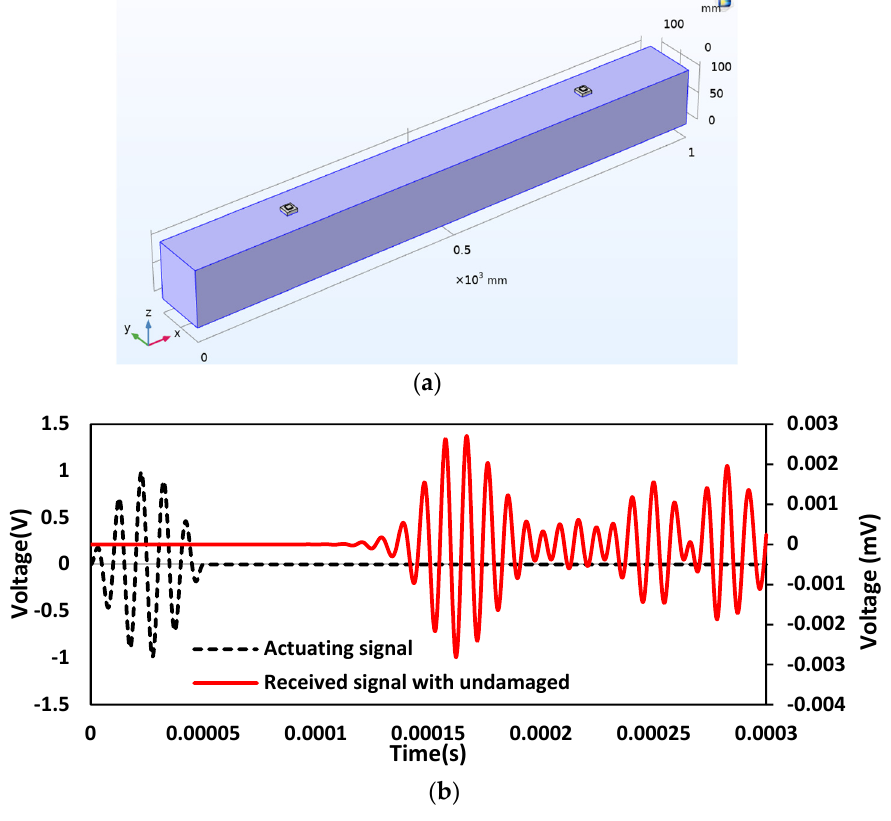
Figure 15. Concrete beam with surface-mounted SSU sensors: ( a ) Schematic 3D model; ( b ) Response spectrum obtained from wave propagation measurements in the actuator–receiver mode.